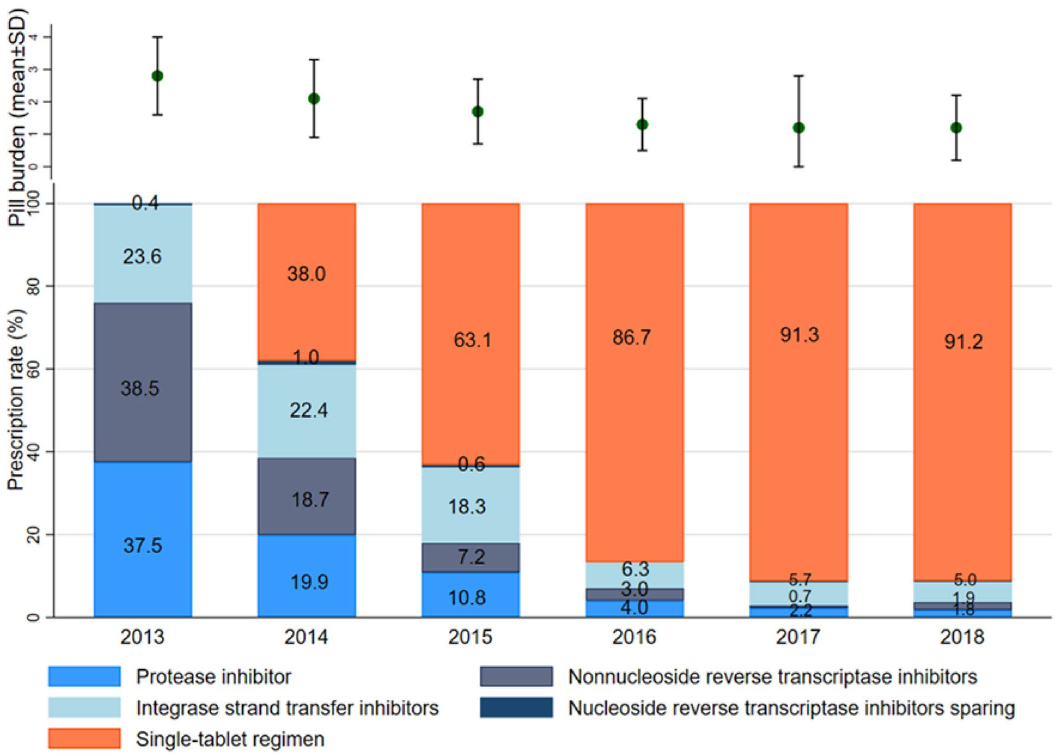
Figure 1. Trends in prescribed ART for treatment-naïve individuals with HIV/AIDS and change of pill burden from 2013 to 2018 in Korea. Proportions are noted in the vertical bars. ART = antiretroviral treatment; SD = standard